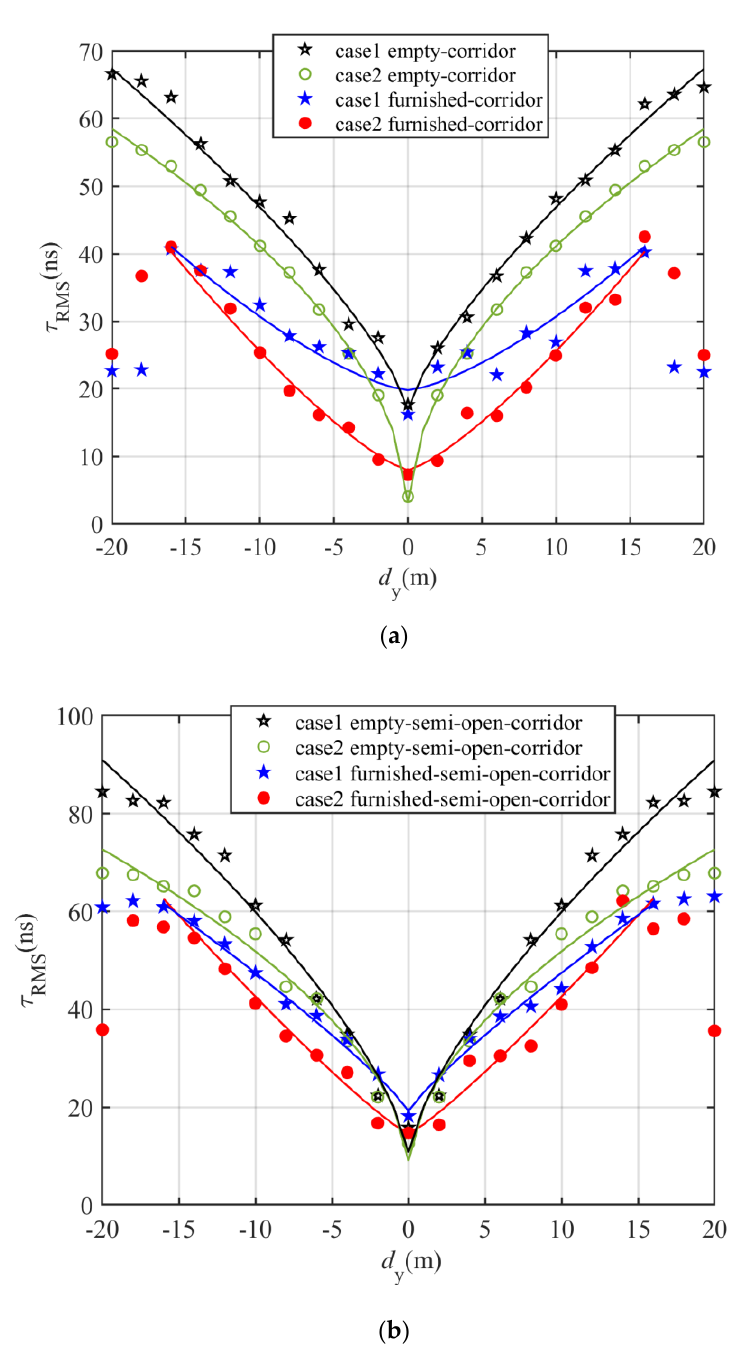
Figure 9. Channel characteristics in term of 𝜏 RMS for both: ( a ) corridor, and ( b ) semi-open corridor environment; when OLED are mounted on the inner shop wall behind the glass window (case1) and on the wall or shop window inside the corridor (case2) while the user is moving along the corridor.